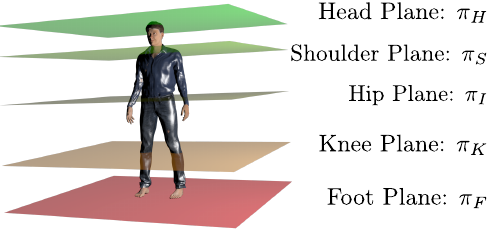
Figure 3. Anthropometric Planes for Human: body joints are tracked on their corresponding planes where λ = scale factor P = projection matrix.